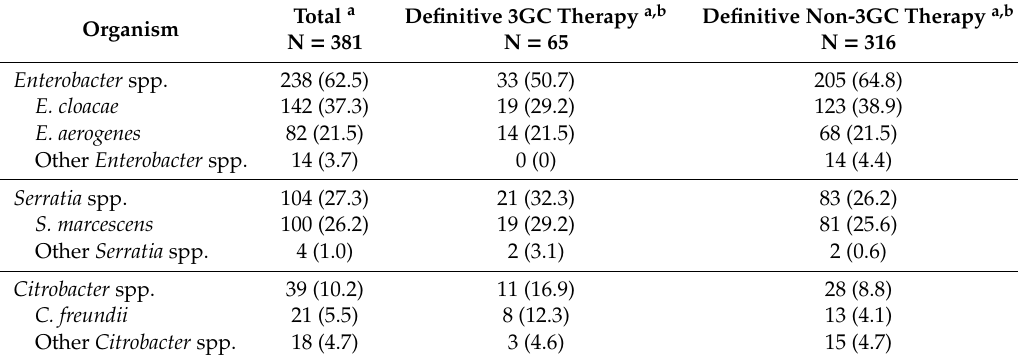
Table 2. Microbiology of bloodstream infections by therapy